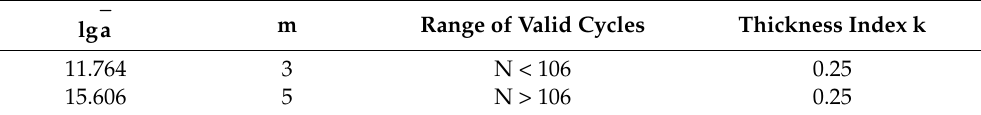
Figure 1. Double-slope S–N curves of tubular joints under air and sea environments. Table 1. S–N curve parameters of tubular joints in a seawater